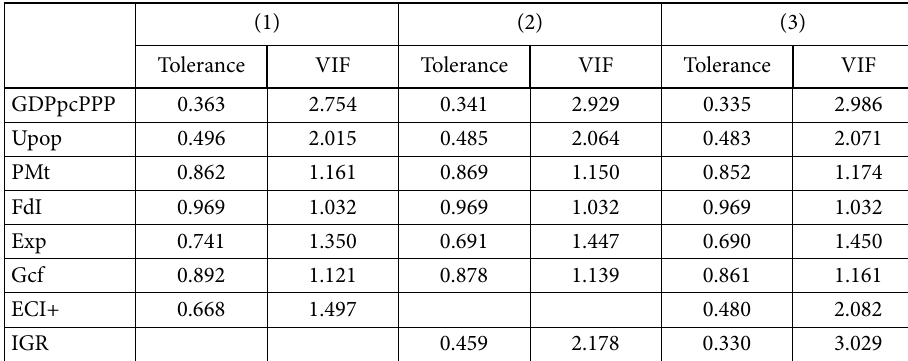
Table 4. Tolerance and Variance Inflation